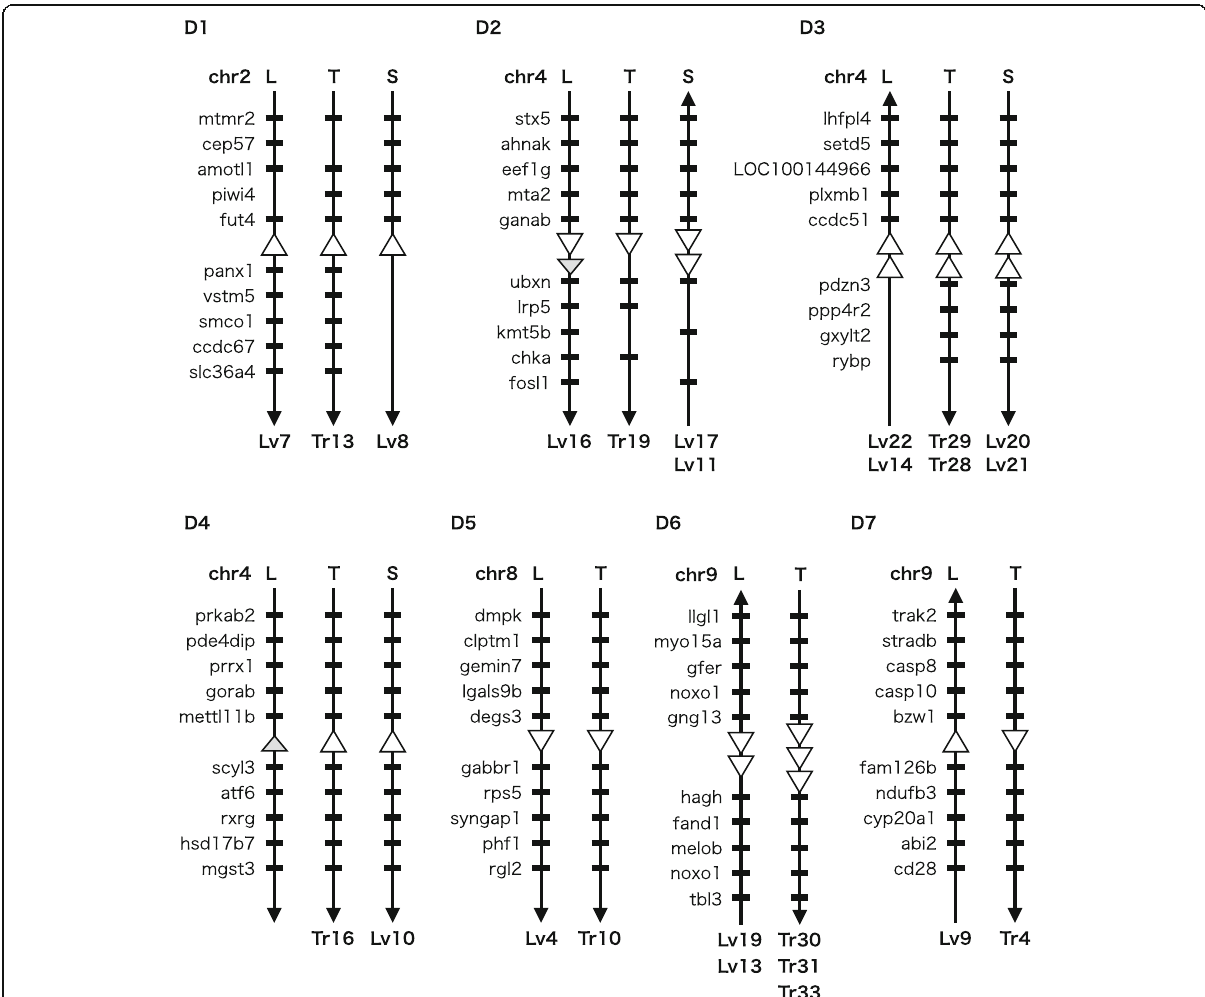
Fig. 4 Synteny of XKol -Tpase genes. Conserved synteny around putative domesticated orthologs of subfamily D1 – D7. Xenopus laevis homeologous chromosomes L and S and Xenopus tropicalis homologous chromosome (T) are indicated by arrows. The orientation of each arrow indicates the 5 ′ to 3 ′ direction. XKol -Tpase CDSs are represented by white triangles on the chromosomes, and their names are shown below the chromosomes. Gray triangles indicate truncated XKol -Tpase sequences. Gene models around the CDSs are represented by black